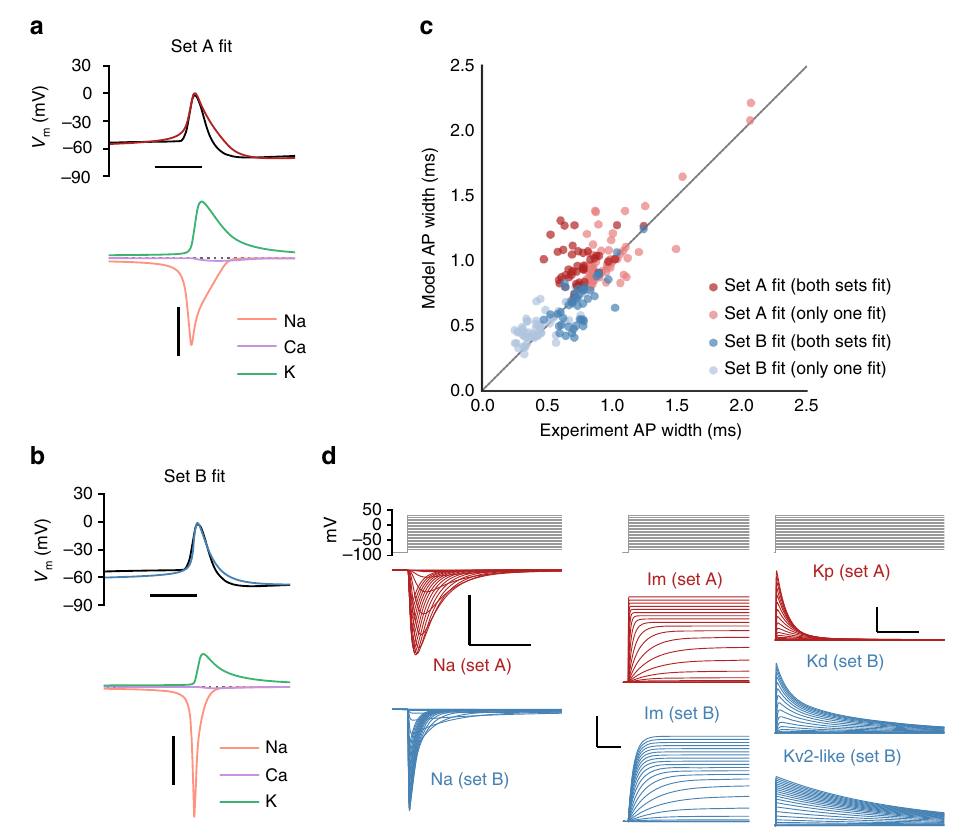
Fig. 3 Modeling narrower spike widths. a Voltage traces of an individual action potential from the experiment (black) and model fi t using conductance set A (red); scale bar, 2 ms. The major currents fl owing during the action potential are shown below; scale bar, 2 nA. b Voltage traces and currents during an individual action potential from the experiment (black) and model fi t using conductance set B (blue); scale bar, 2 ms (horizontal), 2 nA (vertical). c Comparison of model and experimental action potential widths across all models. Red dots are models fi t with conductance set A; blue dots are models fi t with conductance set B. The darker dots represent cases when both types of fi ts were performed on the same cell, which was typically done at intermediate spike widths. d Voltage-clamp measurements of model currents in response to a range of holding potentials ( – 80 mV to +40 mV) from – 90 mV. Currents that are from conductance set A are shown in red. Currents from the set B sodium conductance (left, scale bar: 2 nA vertical, 2 ms horizontal), M-type potassium conductance (middle, scale bar: 5 nA vertical, 50 ms horizontal), and slow potassium conductances (right, scale bar: 3 nA vertical, 500 ms horizontal) are shown in blue. Note that a single slow potassium current in set A was replaced by two potassium conductances in set